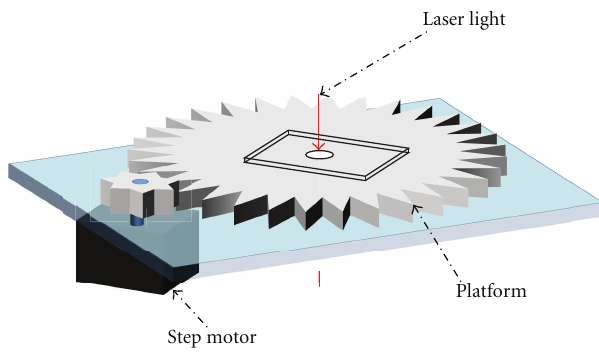
Figure 1: A heterodyne optical source with a 2KHz beat frequency.